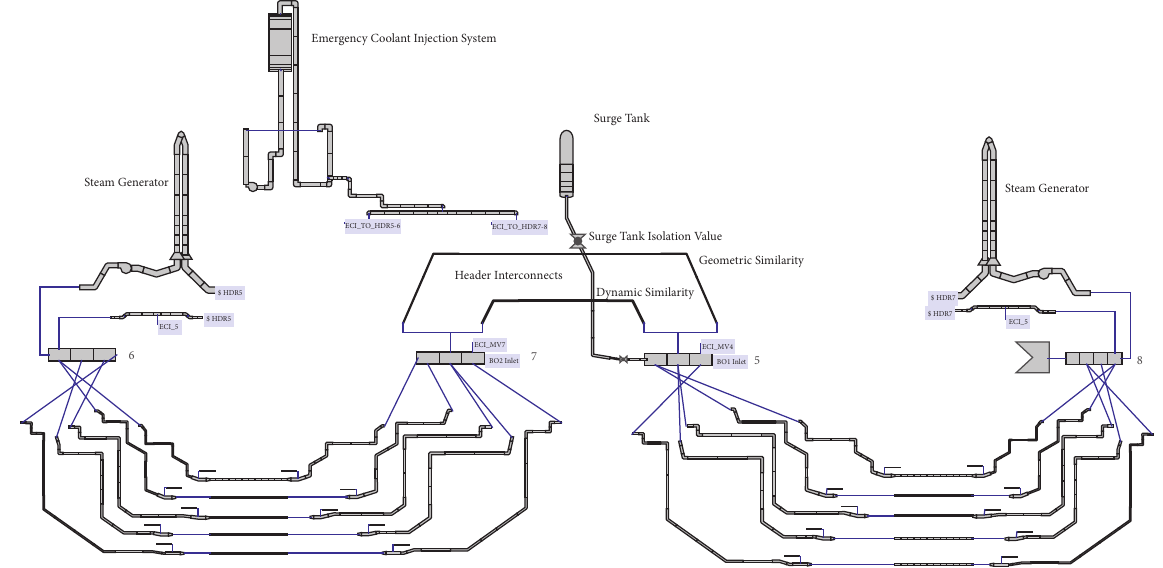
Figure 11: Thermal-hydraulic nodalization of the RD-14M primary side.